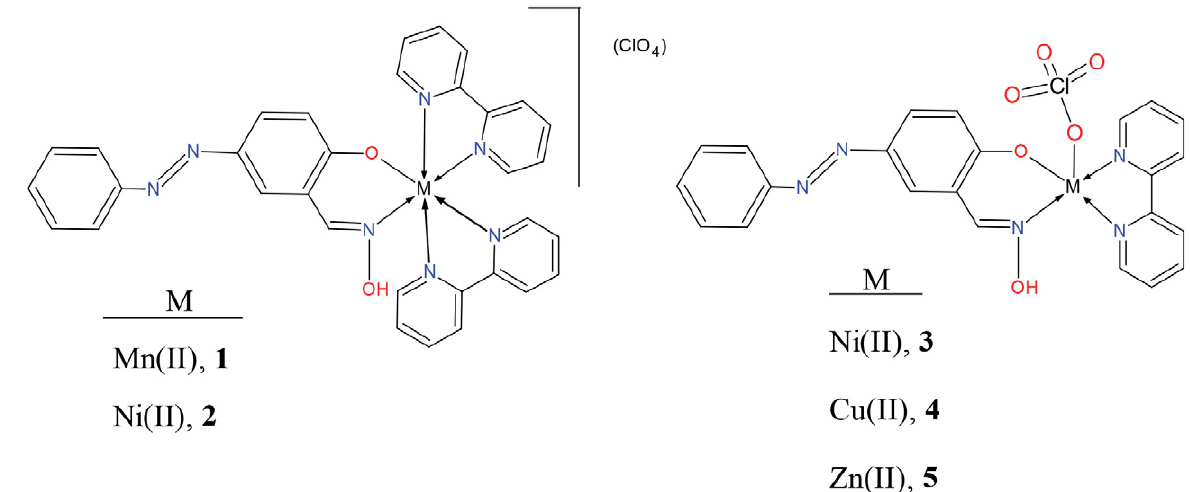
Figure 1: The proposed structures of the complexes ( 1-5 ) in the